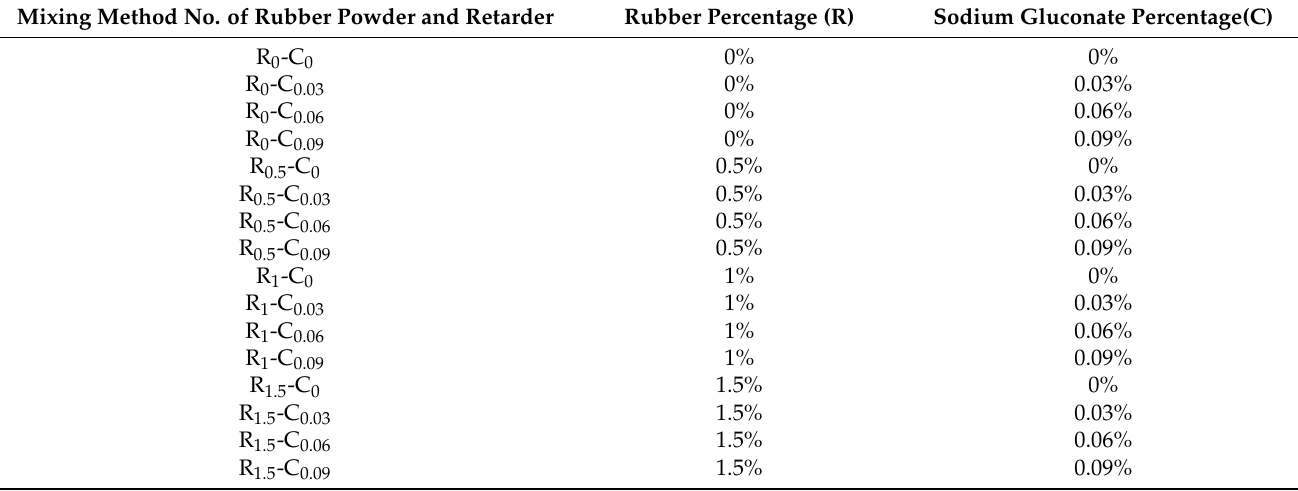
Table 3. Mixing proportion design table of retarded semi-rigid base mixed with rubber powder. Mixing Method No. of Rubber Powder and Retarder Rubber Percentage